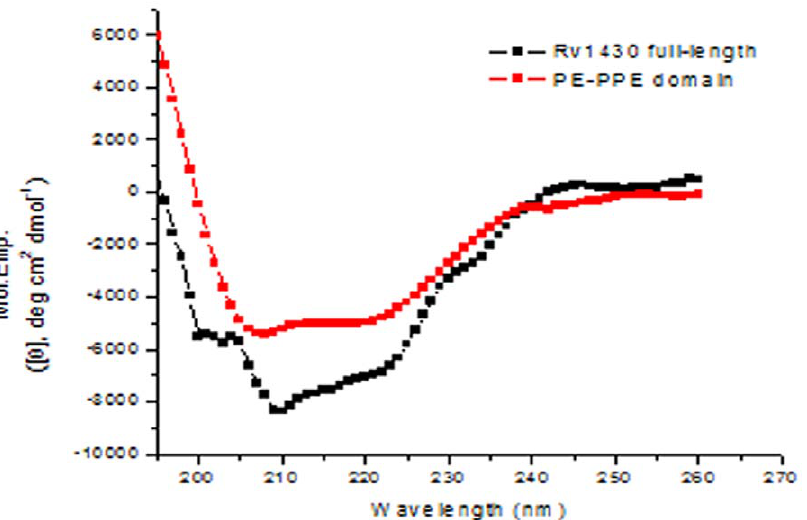
Figure 3. CD spectra of Rv1430 full-length (black) and its PE-PPE domain (red) measured in10 mM Tris, at pH 7.0.